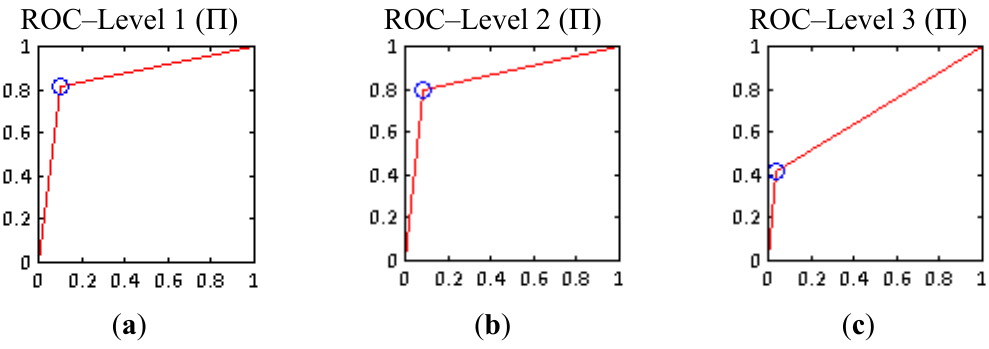
Figure 15. Multiplicative method ( Π ) ROC curves ( a ) Level 1; ( b ) Level 2; ( c ) Level